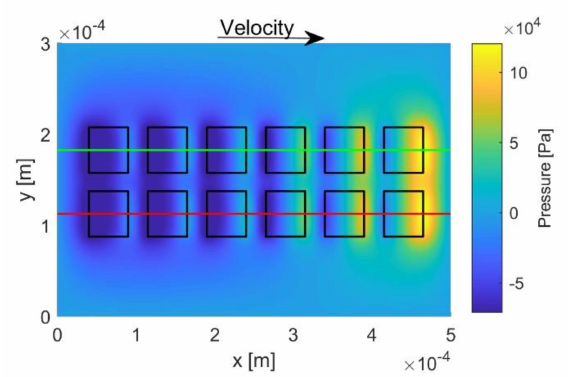
Figure 13. Pressure contour of a multi-row configuration. Square dimples with side 50 µ m and depth 10 µ m. Gap 5 µ m, sliding velocity 5 m / s.